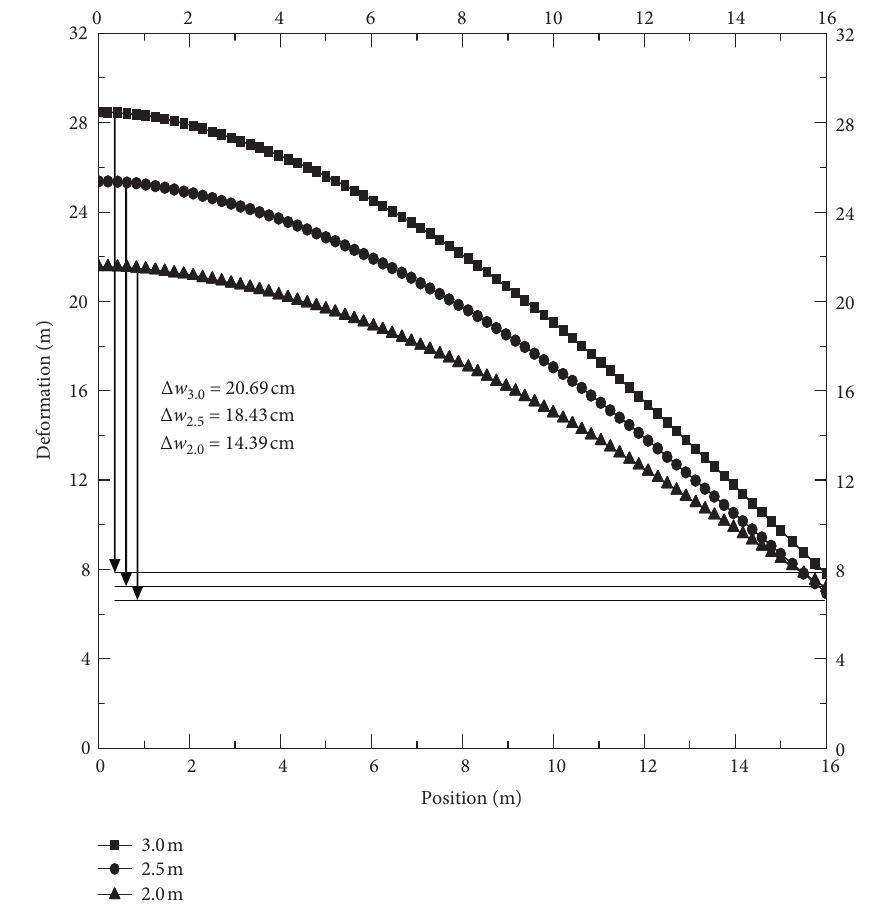
Figure 8: Deformation versus time with different pile spacing.